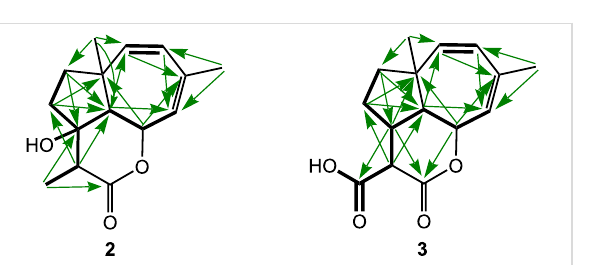
Figure 2: KEY HMBC (arrows) and COSY (thick bonds) correlations of compounds 2 and 3 .